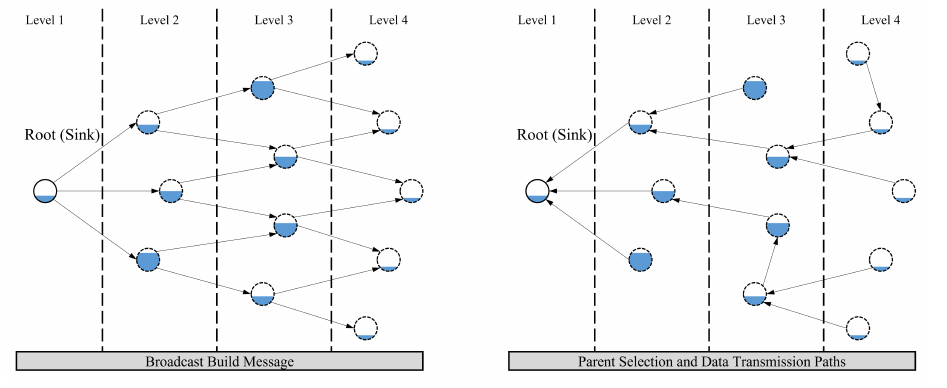
Figure 3. An illustration of tree-based routing.